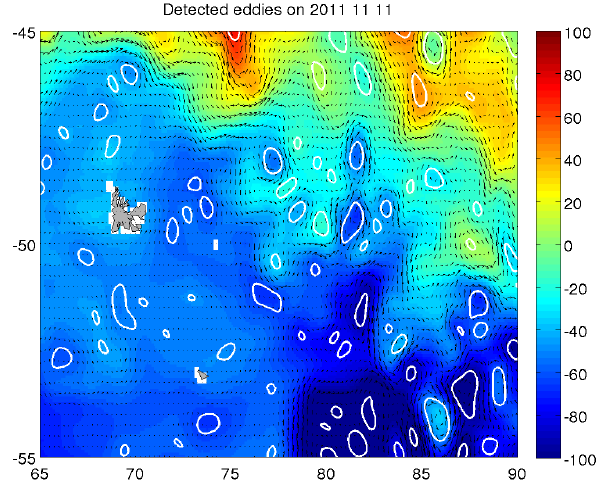
Figure 2. Sea surface height and eddy contours (11 November